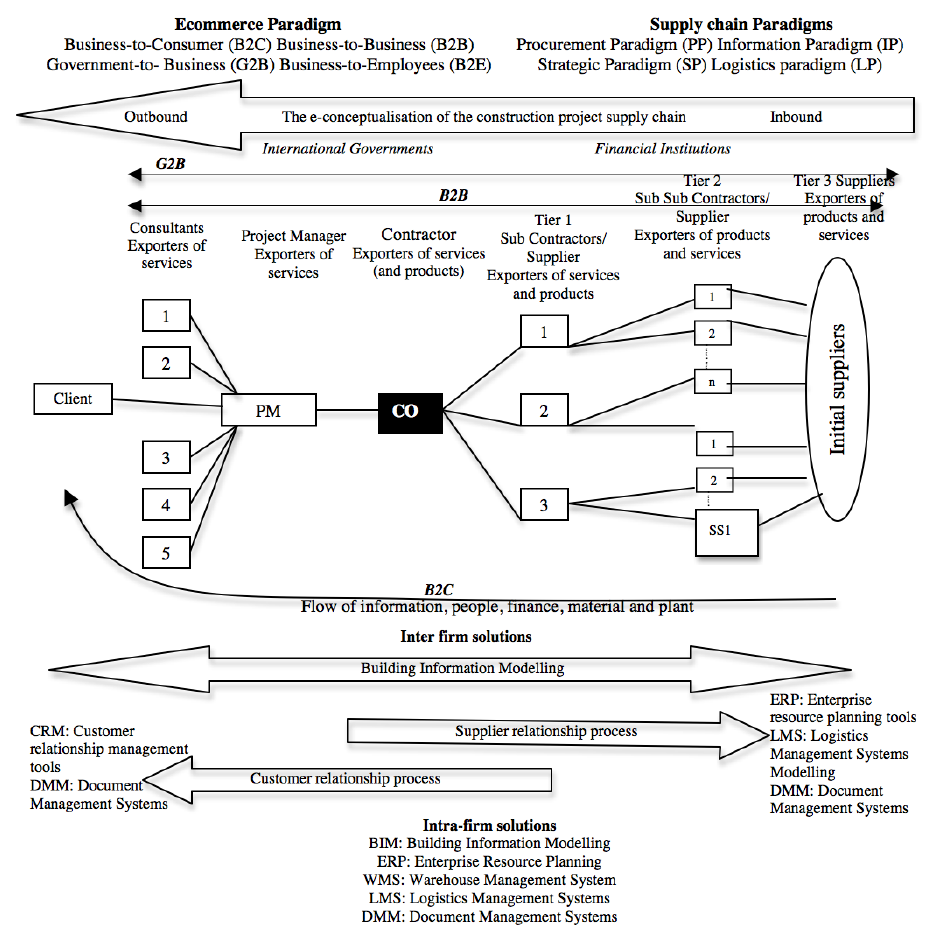
Figure 3 E-commerce in construction supply